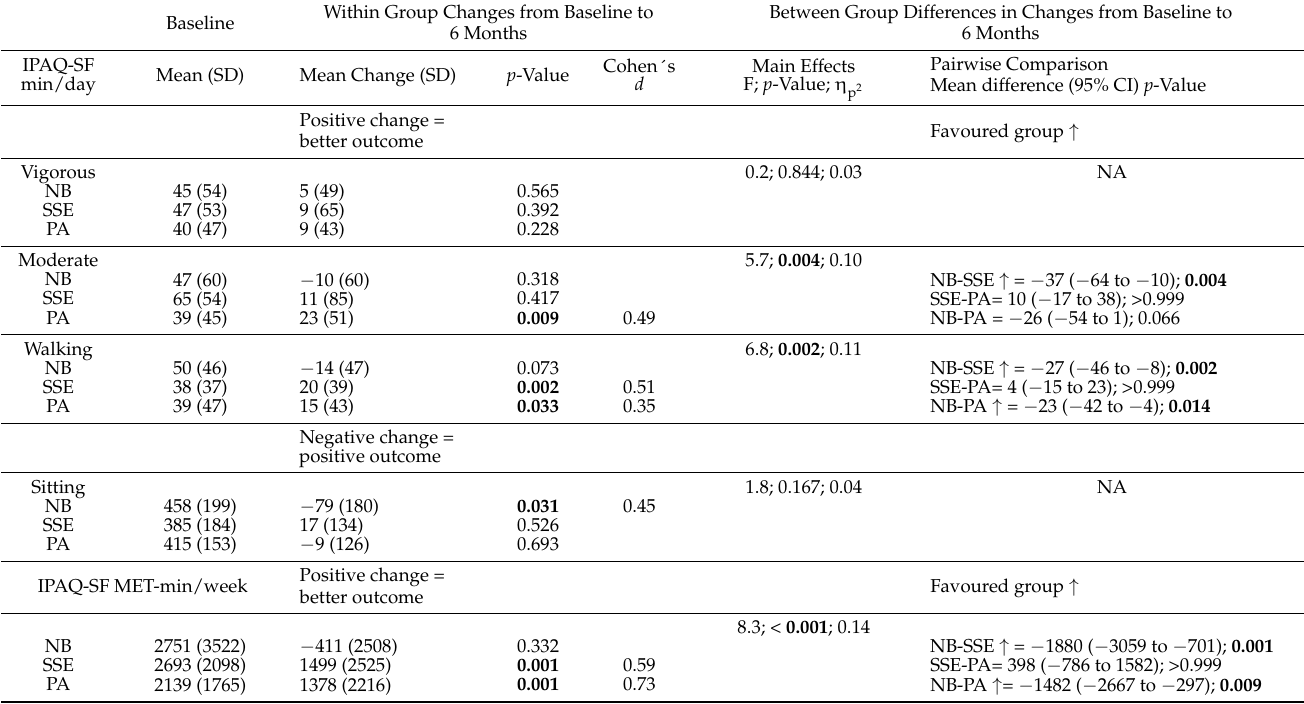
Table 3. Physical activity levels for the IPAQ-SF in min/day and MET-min/week at baseline, within group change and between group differences in change between baseline to 6